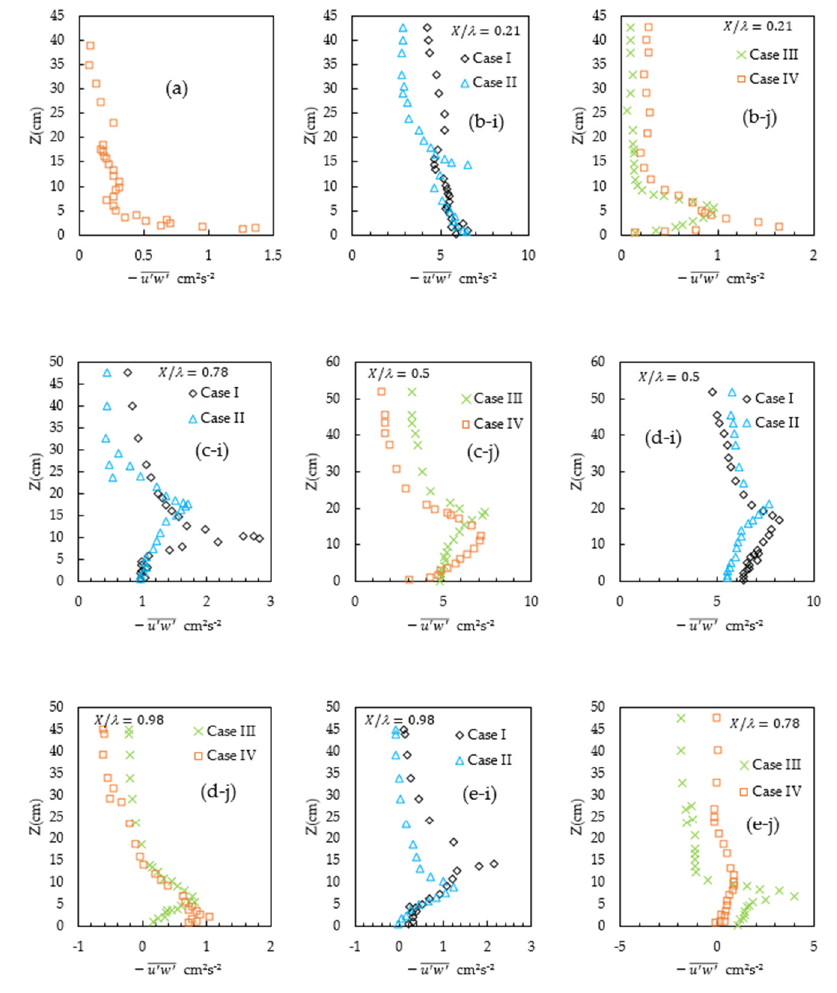
Figure 6. Profiles of the Reynolds stress − u (cid:48) w (cid:48) along the channel centerline for all Cases. ( a ) The upstream section of the pool ( X/ λ = 0.017 ), ( b-i , b-j ) the pool entrance ( X/ λ = 0.21 ), ( c-i , c-j ) the middle of the pool ( X/ λ = 0.5 ), ( d-i , d-j ) the pool exit ( X/ λ = 0.78 ,) and ( e-i , e-j ) the downstream section of the pool ( X/ λ = 0.98 ).